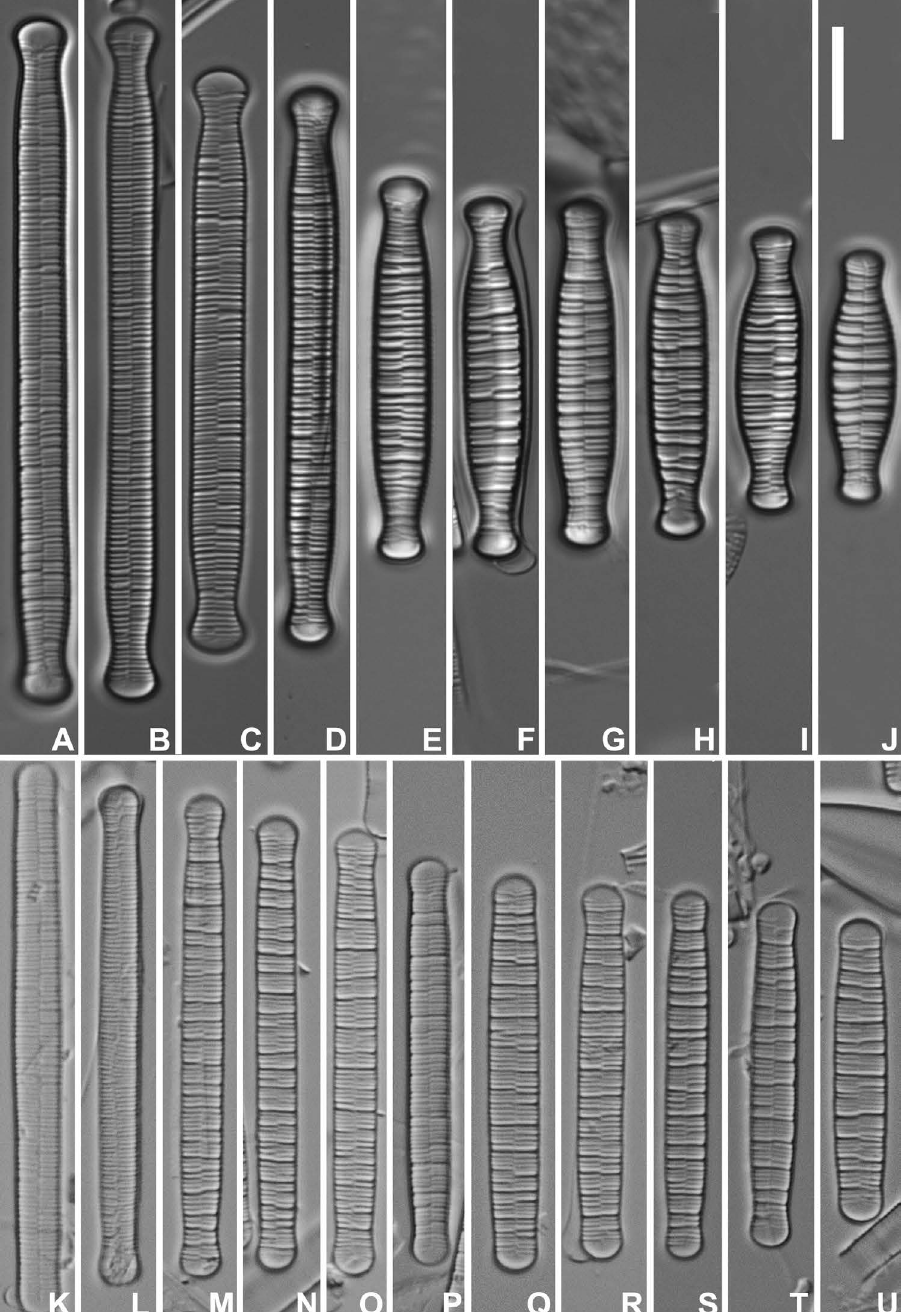
Figure 4 – Distrionella germainii . Different populations from the sub-Antarctic Region. LM views of valves in valve face view showing the observed size range and the variability of the transapical ribs and the valve outline: A–J, population from Val Studer, Iles Kerguelen (sample KER-BM518); K–U, population from Stromness Bay, South Georgia (sample SG-W374). Scale bar = 10